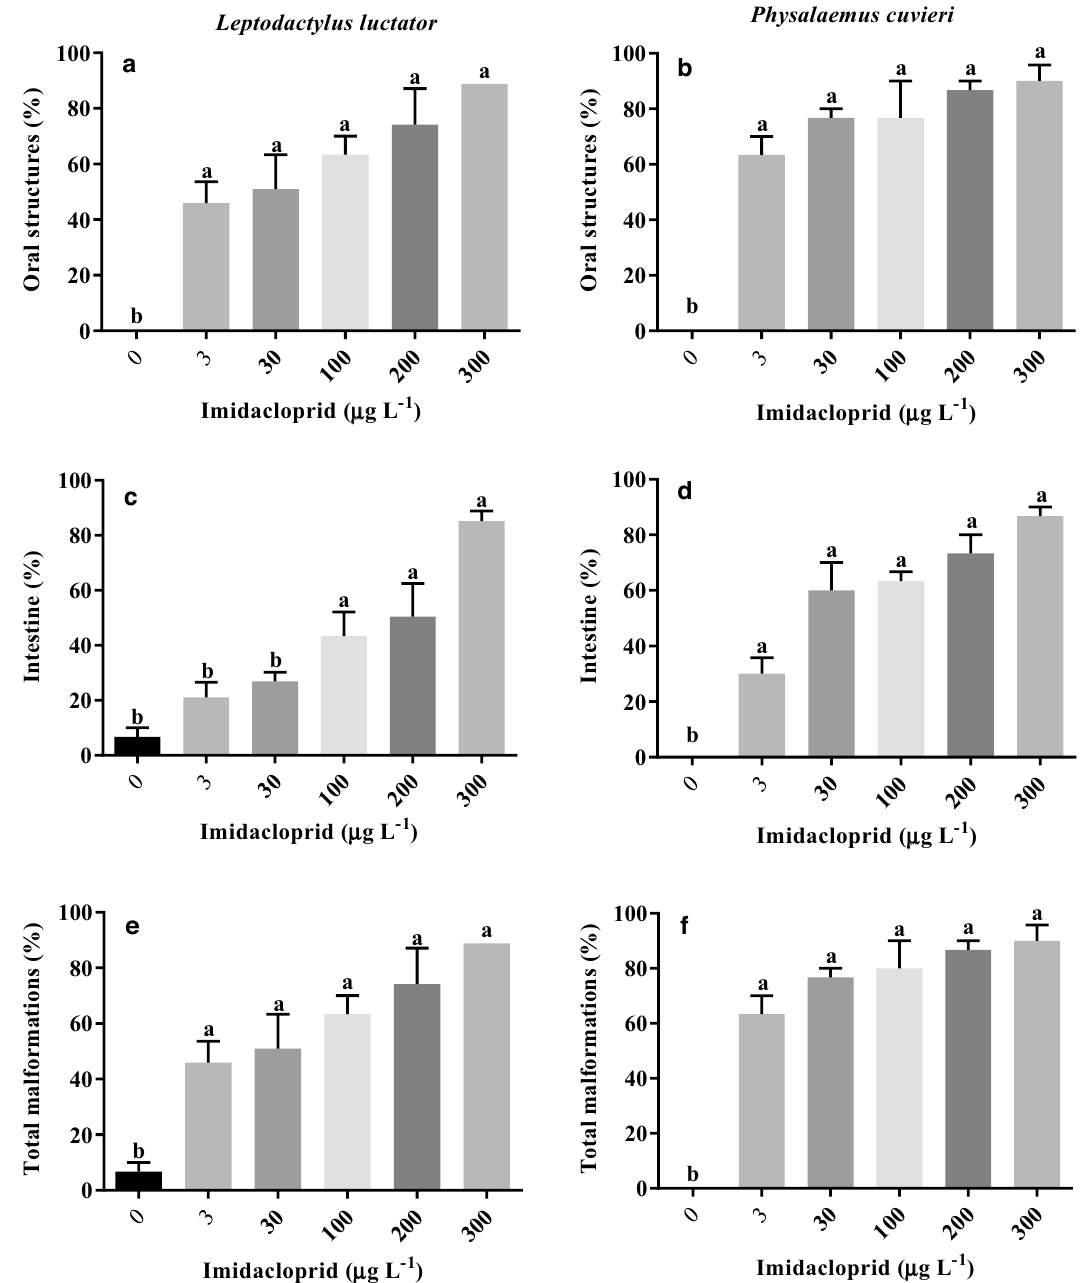
Figure 2. Percentage of occurrence of malformations in the oral structures, intestine, and total malformations (oral structures + intestine) in the tadpoles of Leptodactylus luctator ( a , c , e ) and Physalaemus cuvieri ( b , d , f ) exposed to different concentrations of an imidacloprid based-insecticide for 168 h. The bars represent the mean ± SEM (n = 3). Different letters above pairs of columns indicate significantly different results according to Dunnett’s test (p <